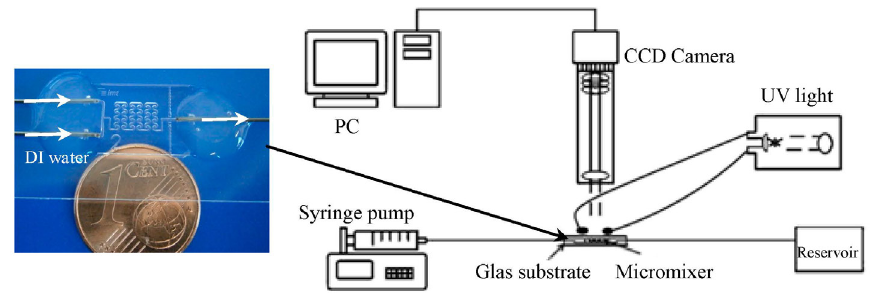
Figure 9. Fabricated micromixer and experimental